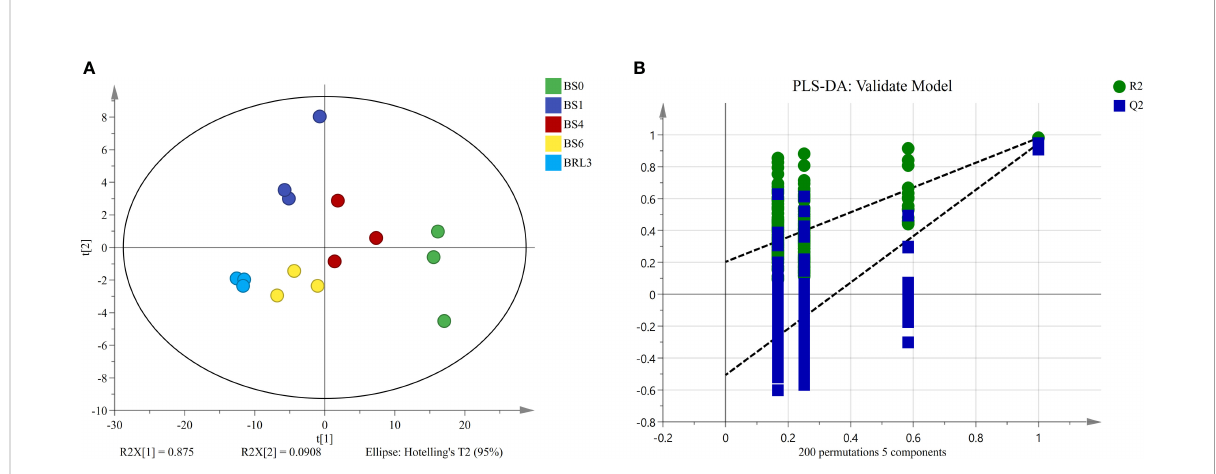
FIGURE 2 Unsupervised and supervised multivariate analysis of the detected lipids in BJG. (A) PCA score plot. (B) PLS-DA cross-validation plot.